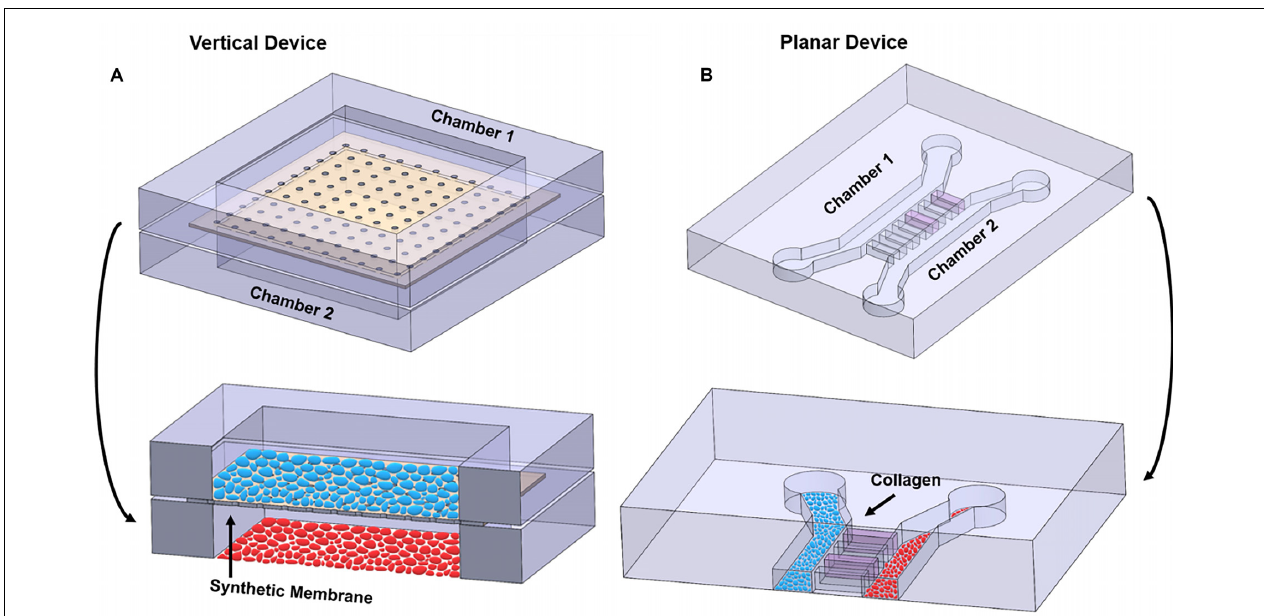
FIGURE 4 | Illustration highlighting the differences between vertical and planar co-culture OOC designs. (A) 3D view of two cell culture chambers, stacked on top of each other, to form a “vertical co-culture” OOC device. These two chambers are separated by a semipermeable synthetic membrane (tan structure; black arrow), which contains small pores for cell migration and signal propagation, but too small for cells to freely move between the layers. Blue ellipses are grown on top of the membrane, while red ellipses are grown on the bottom glass substrate. Red and blue ellipses represent two distinct cell populations. (B) 3D view of two cell culture chambers aligned next two each other and separated by a set of microchannel arrays to form a “planar co-culture” OOC device. These two chambers are separated by microchannels that can be filled with collagen (pink; black arrow), providing an actual cell–collagen interface. Both blue and red ellipses are grown the bottom glass substrate but in separate chambers. Red and blue ellipses represent two distinct cell populations. The sizes of the microchannels are small enough to prevent cells from freely moving between the culture compartments but large enough for actively migrating cells and biochemicals to move between the compartments. Alternatively, these microchannel arrays can be replaced with a porous gel